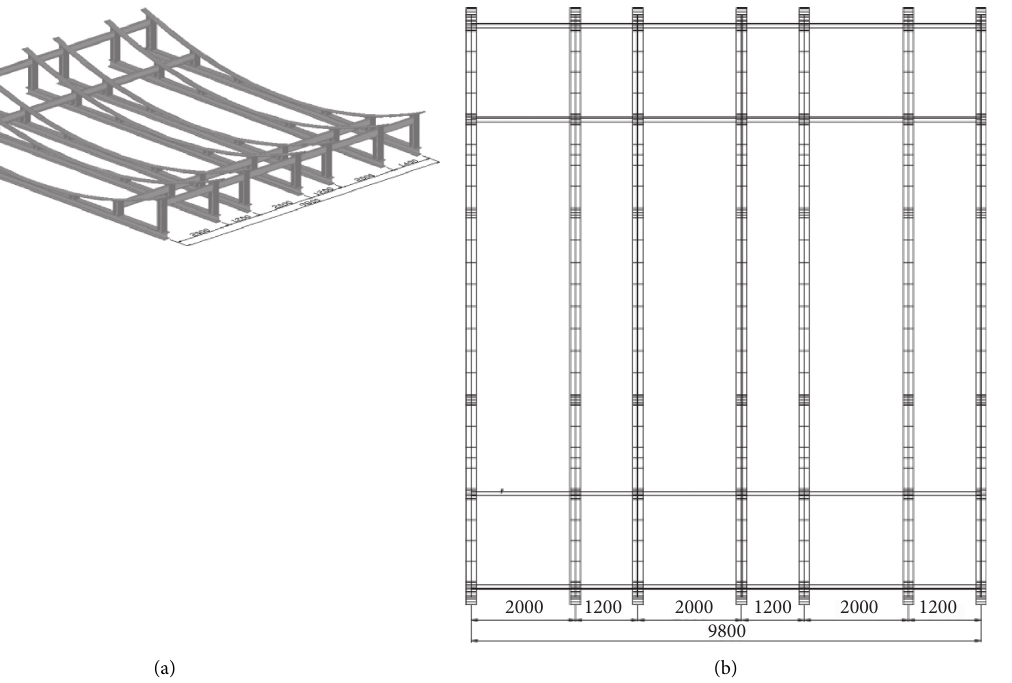
Figure 13: Upper assembly jig: (a) 3D model; (b) top view.